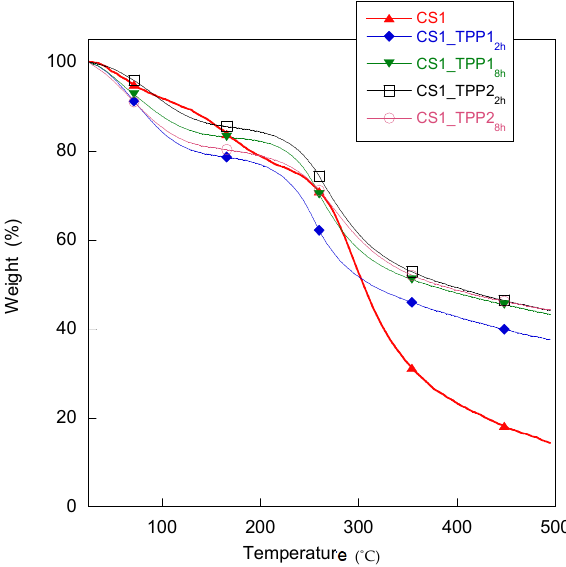
Figure 4. Thermogravimetric curves of CS1 and CS1_TPP scaffold obtained at different cross-linking Figure 4. conditions.